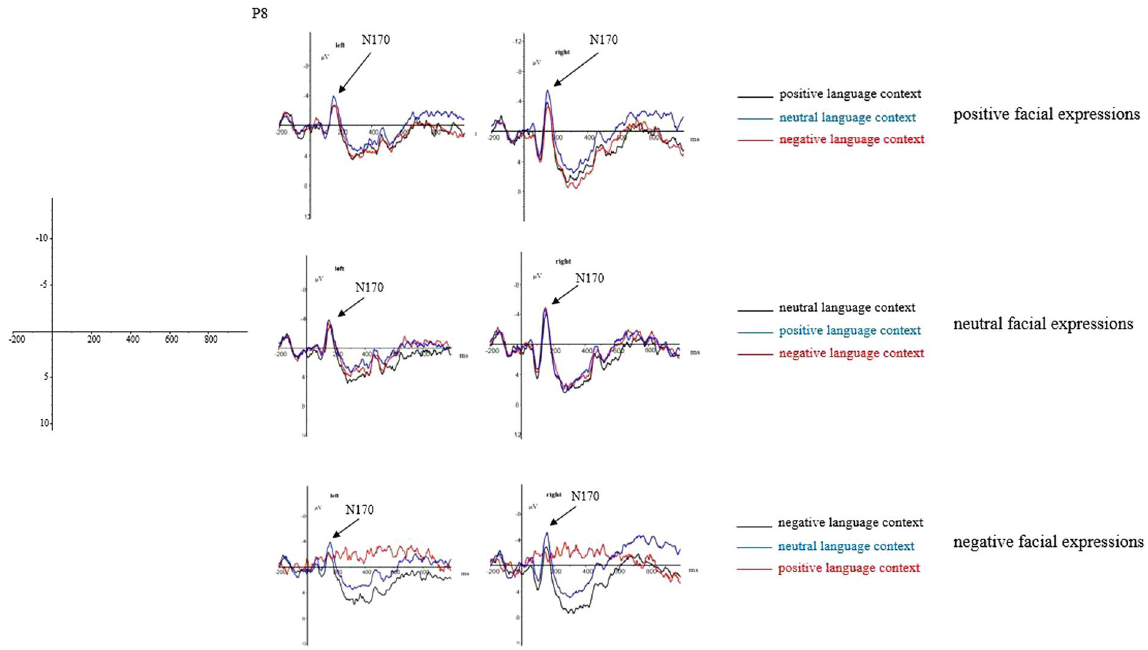
Figure 3. The grand-average ERPs elicited by positive, neutral, and negative facial expressions in different language contexts at P8 site.